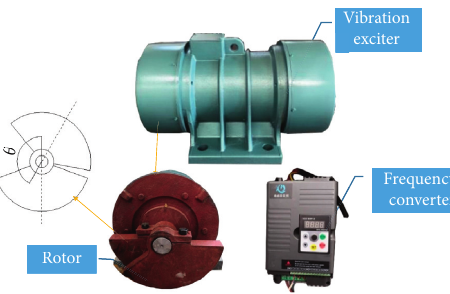
Figure 3: The vibration exciter equipment. Table 3: Pile-driving vibration data of a foundation pit.